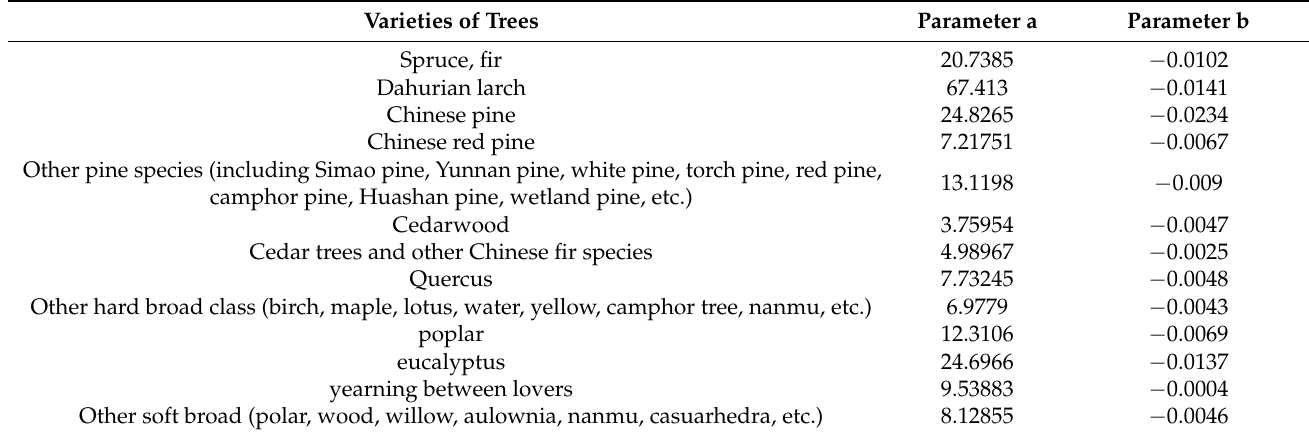
Table 2. Reference values of the parameters a and